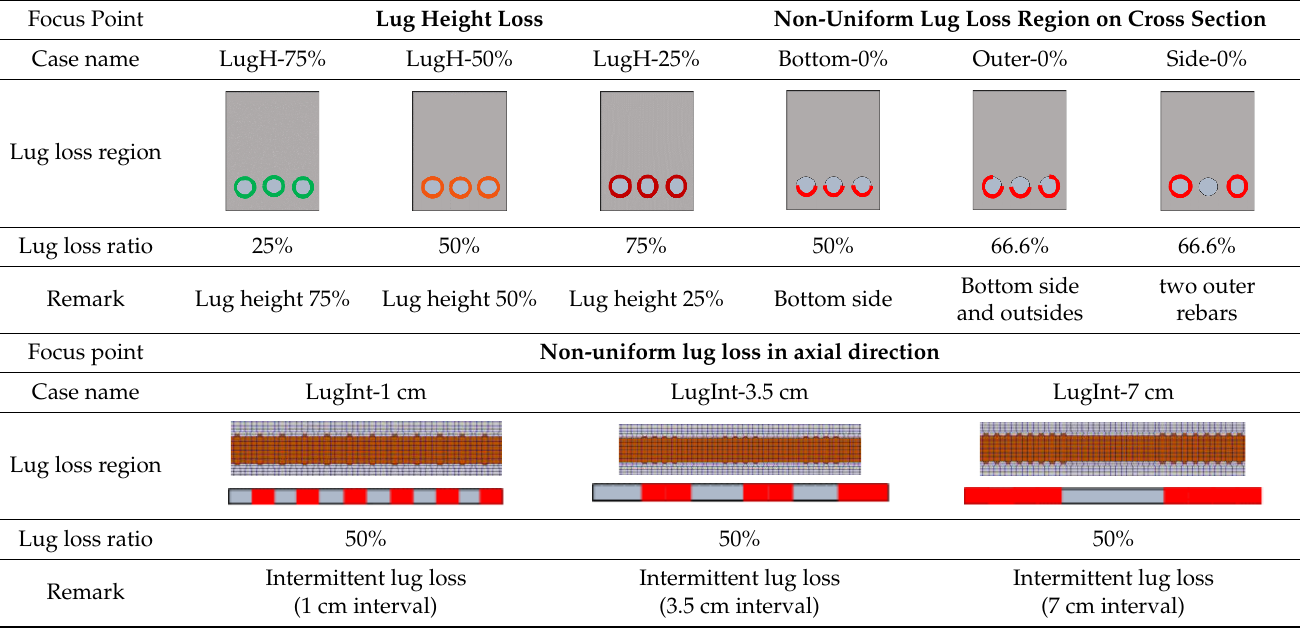
Table 5. List of analysis cases.